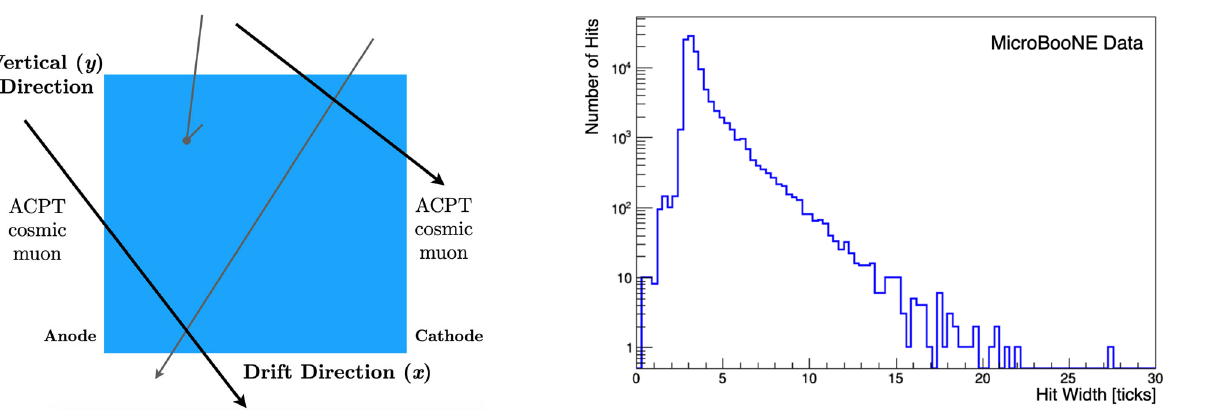
Fig. 2 Illustration of two examples of anode/cathode piercing tracks (ACPT), shown in black. The track must cross at least one of the anode or the cathode. The other tracks, shown in gray, are cosmic muons that do not satisfy the ACPT criteria